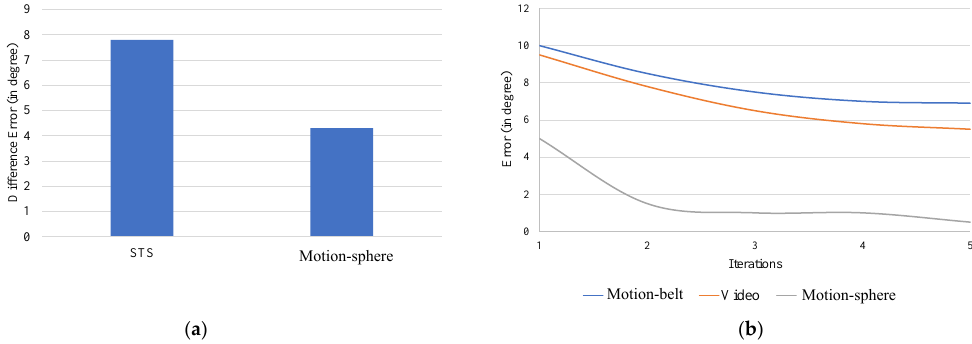
Figure 15. ( a ) Average error as predicted by the participants against ground truth ( b ) Learnability of Motion-sphere against Video and Motion-belt, accuracy of the prediction over